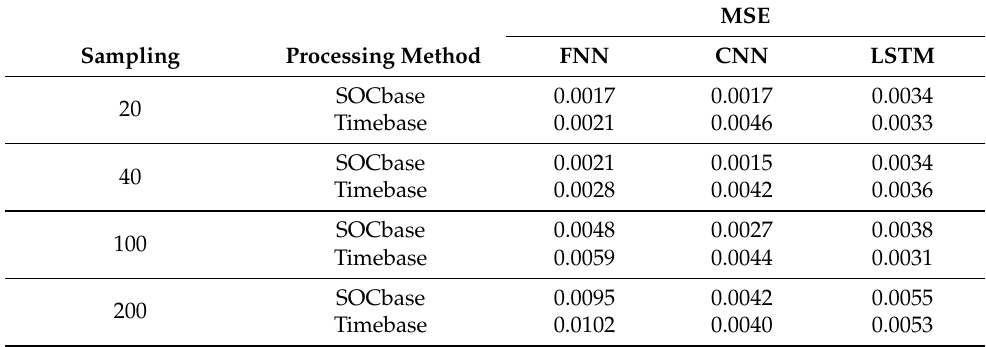
Table 3. The MSE loss dependency on the number of sampling points in FNN, CNN, and LSTM.